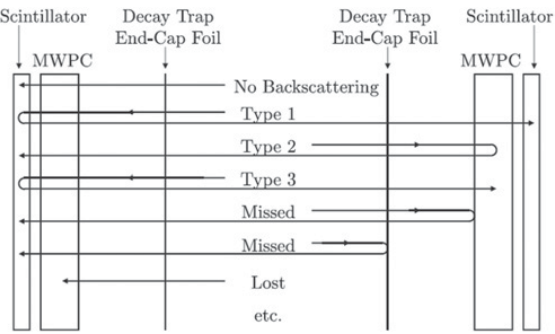
Figure 3. Schematic of potential backscattering events for a single β -decay electron [6]. Our analysis focuses on Type 1 backscatters.